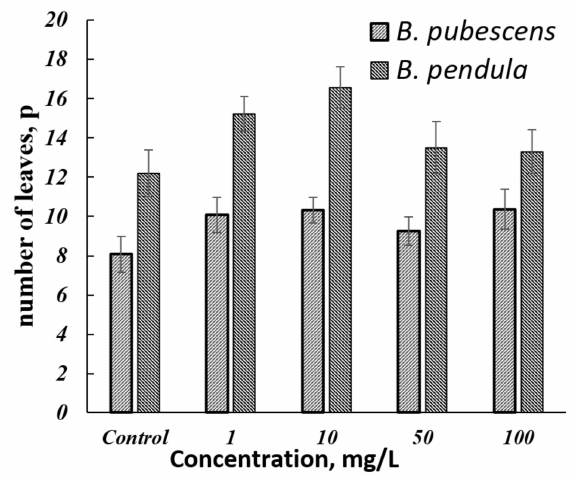
Figure 8. Average number of leaves per plant.